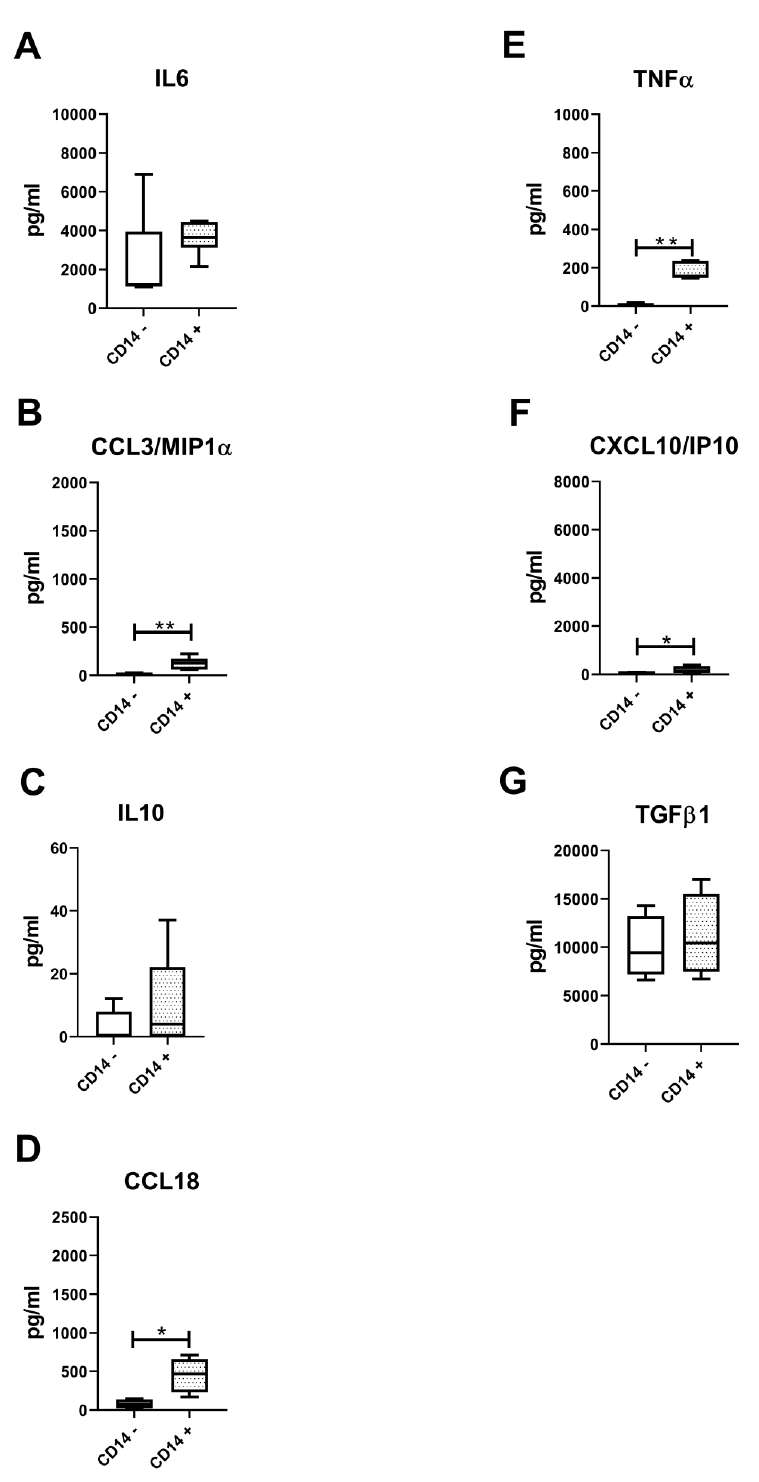
Figure 8. Evaluation of cytokines typical of synovial M1- and M2-like macrophages. ( A ) IL6, ( B ) CCL3 / MIP1 α , ( C ) IL10, ( D ) CCL18, ( E ) TNF α , ( F ) CXCL10 / IP10, ( G ) TGF β 1 typical cytokines of M1 and M2-type macrophages evaluated at the protein level on pure CD14 negative (CD14 − ) and CD14-positive (CD14 + ) cells isolated from OA synovium ( n = 4). Data are expressed as pg / mL and represented as box plots with median, minimum and maximum. Significant results among groups (* p < 0.05, ** p < 0.01) were reported (Mann–Whitney U test was used to compare the two